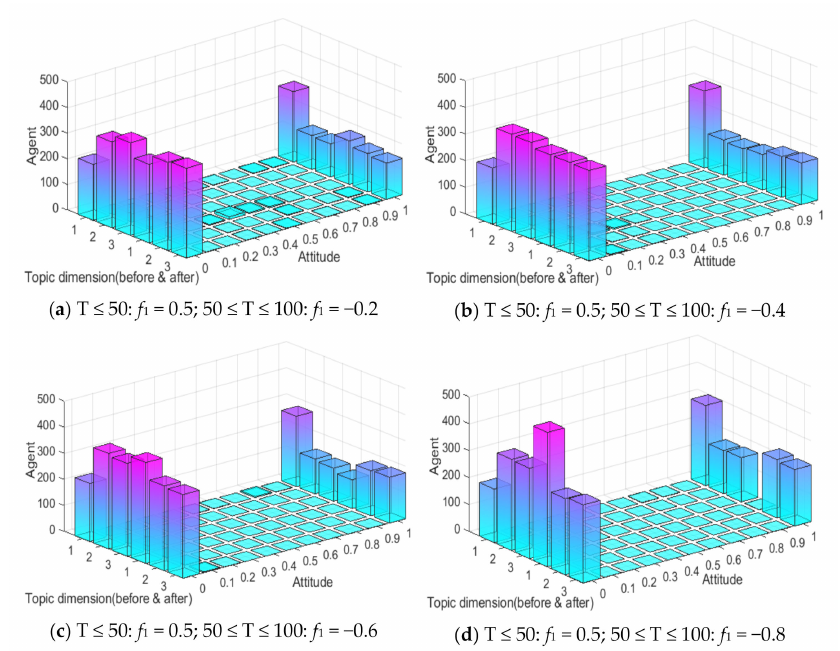
Figure 18. Histogram of group attitude distribution at different moments under different information